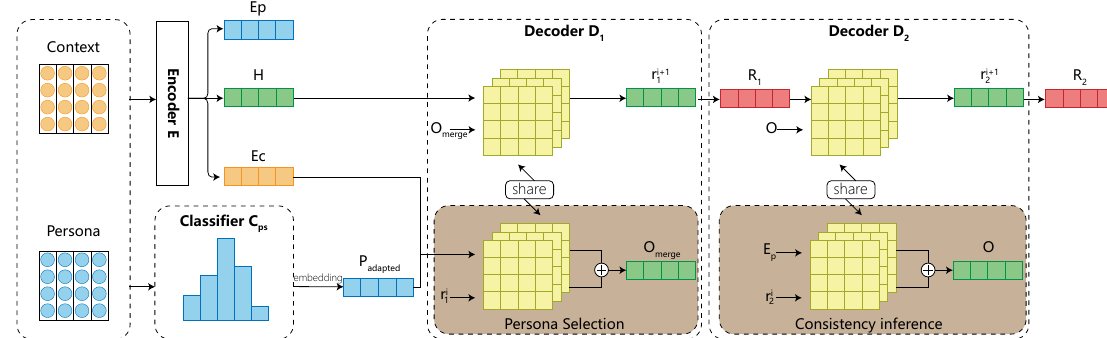
Figure 3. The architecture of the proposed persona-adapted and -consistent dialogue